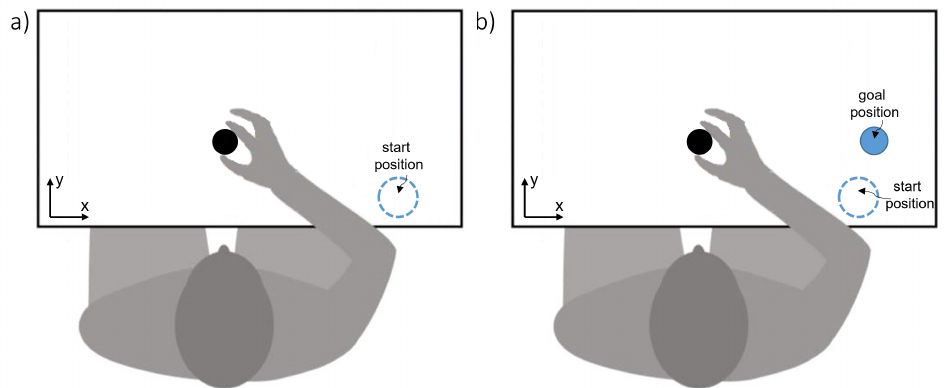
Figure 1. ( a ) Experimental setup for the “weight assessment” and “lifting” condition. Seated participants performed the instructed grasping movement with their right hand. Following the experimenter’s instruction, the sphere was taken from the starting position to execute the grasping action. Once completed, the sphere was released at its original position, and the participants returned to the start position. ( b ) Experimental setup for the “transporting” condition. Seated participants performed the instructed grasping movement with their right hand. Following the experimenter’s instruction, the sphere was taken from the starting position to execute the grasping action. The sphere was transported and released at the goal position, and the participants returned to the start position. ( a , b ) Once participants returned to the start position, a second object was brought by the experimenter, and the task was repeated. Participants were asked to judge the similarity of both objects’ features, taking into account the executed grasping movement. Finally, the experimenter recorded the answer on a pre-specified score sheet, terminating the trial. In all conditions, the participants had uncovered eyes and used their right hand only. The same sixteen 3D-printed objects were used throughout the